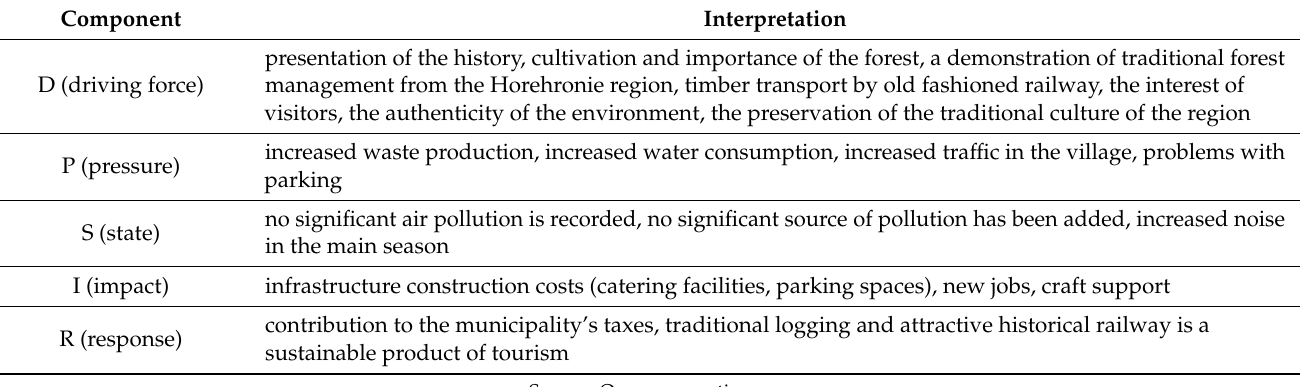
Table 5. DPSIR model for ˇCierny